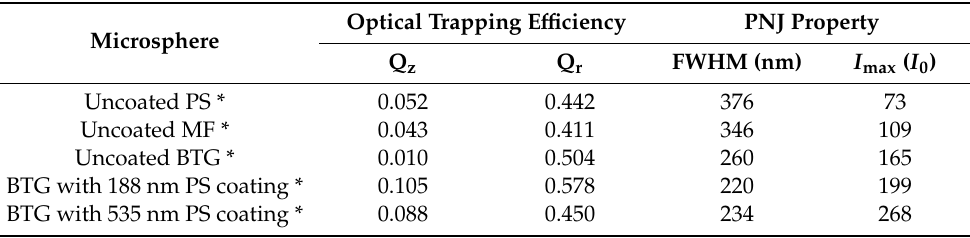
Table 1. Optical trapping e ffi ciency and PNJ property of di ff erent microspheres in water. Optical Trapping E ffi ciency PNJ Property Microsphere Q z Q r FWHM (nm) I max ( I 0 ) Uncoated PS * 0.052 0.442 Uncoated MF *